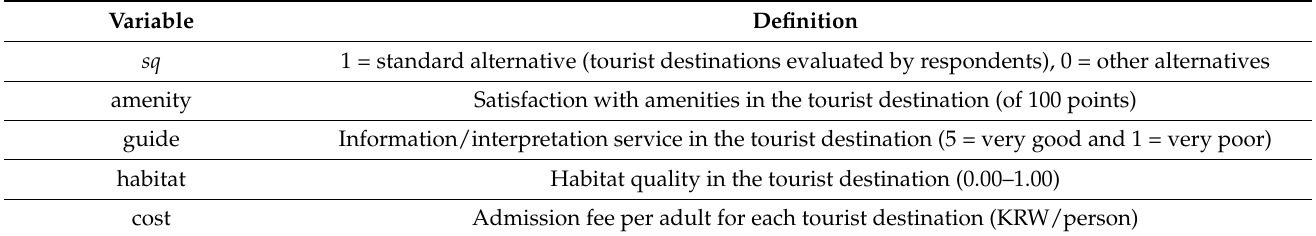
Table 3. Variable and definitions used in the econometric model.